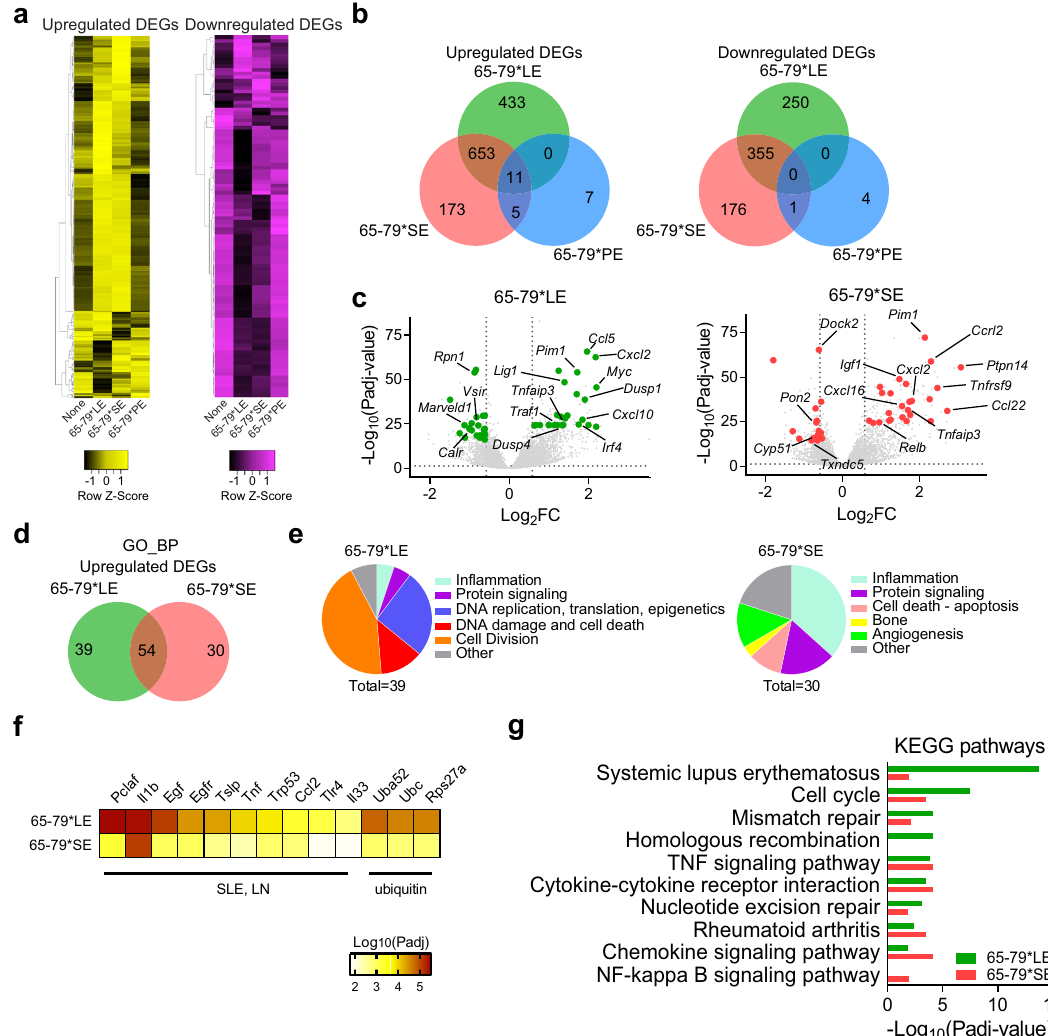
Fig. 1 Transcriptional modulation by the LE (Model A: epitope + IFN- γ , versus IFN- γ alone). a Heatmaps showing unsupervised clustering of upregulated (left, yellow) and downregulated (right, purple) DEGs for 65-79*LE, 65-79*SE and 65-79*PE. DEGs were selected based on a > 3-fold change for 65-79*LE. All depicted DEGs had a P adj < 0.05. b Venn diagrams showing comparison of DEGs for 65-79*LE, 65-79*SE and 65-79*PE. c Volcano plots comparing transcriptional modulation by 65-79*LE and 65-79*SE. Green dots denote SLE-relevant genes modulated by 65-79*LE; red dots denote RA-relevant genes modulated by 65-79*SE. d Venn diagram comparing GO-BP terms enrichment among upregulated DEGs for 65-79*LE versus 65-79*SE. e Pie charts showing differential thematic clustering of unique GO-BP term enrichment among 65-79*LE- (left) versus 65-79*SE- (right) upregulated DEGs. f Heatmap of top-ranked SLE- or ubiquitination-associated URs that are predicted to be involved in 65-79*LE transcriptional modulation, as compared to their predicted involvement in 65-79*SE transcriptional modulation. g Notable KEGG pathway enrichment among 65-79*LE-upregulated DEGs, versus 65- 79*SE. Data in ( b – g ) are based on DEGs with a fold change >1.5 and P adj < 0.05. All data are based on 6 biological replicates in 2 independent experiments. See also Supplementary Tables 1 and